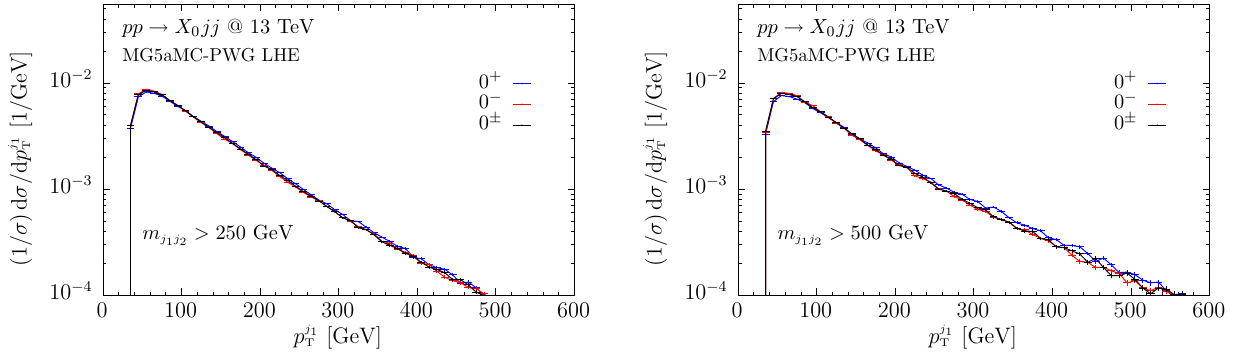
Fig. 4 Normalised differential cross section as a function of the transverse momentum of the leading jet, for the three CP scenarios. On the left panel, a cut of 250 GeV is imposed on the dijet mass, while on the right panel a cut of 500 GeV is applied. The colour code is the same as in Fig. 1